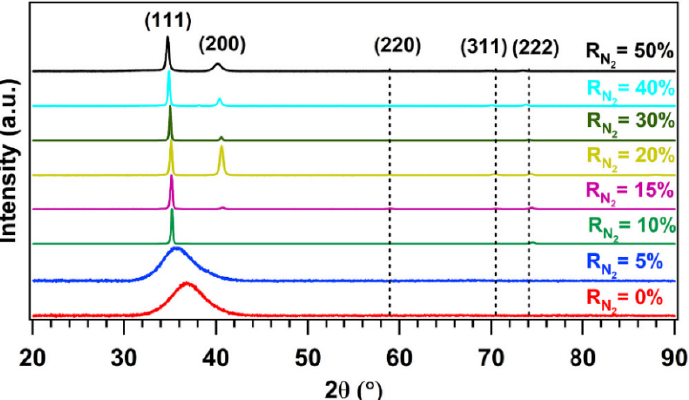
Figure 7. XRD patterns of the AlTiTaZrHf(N) HEA films in function of R N2 [66].